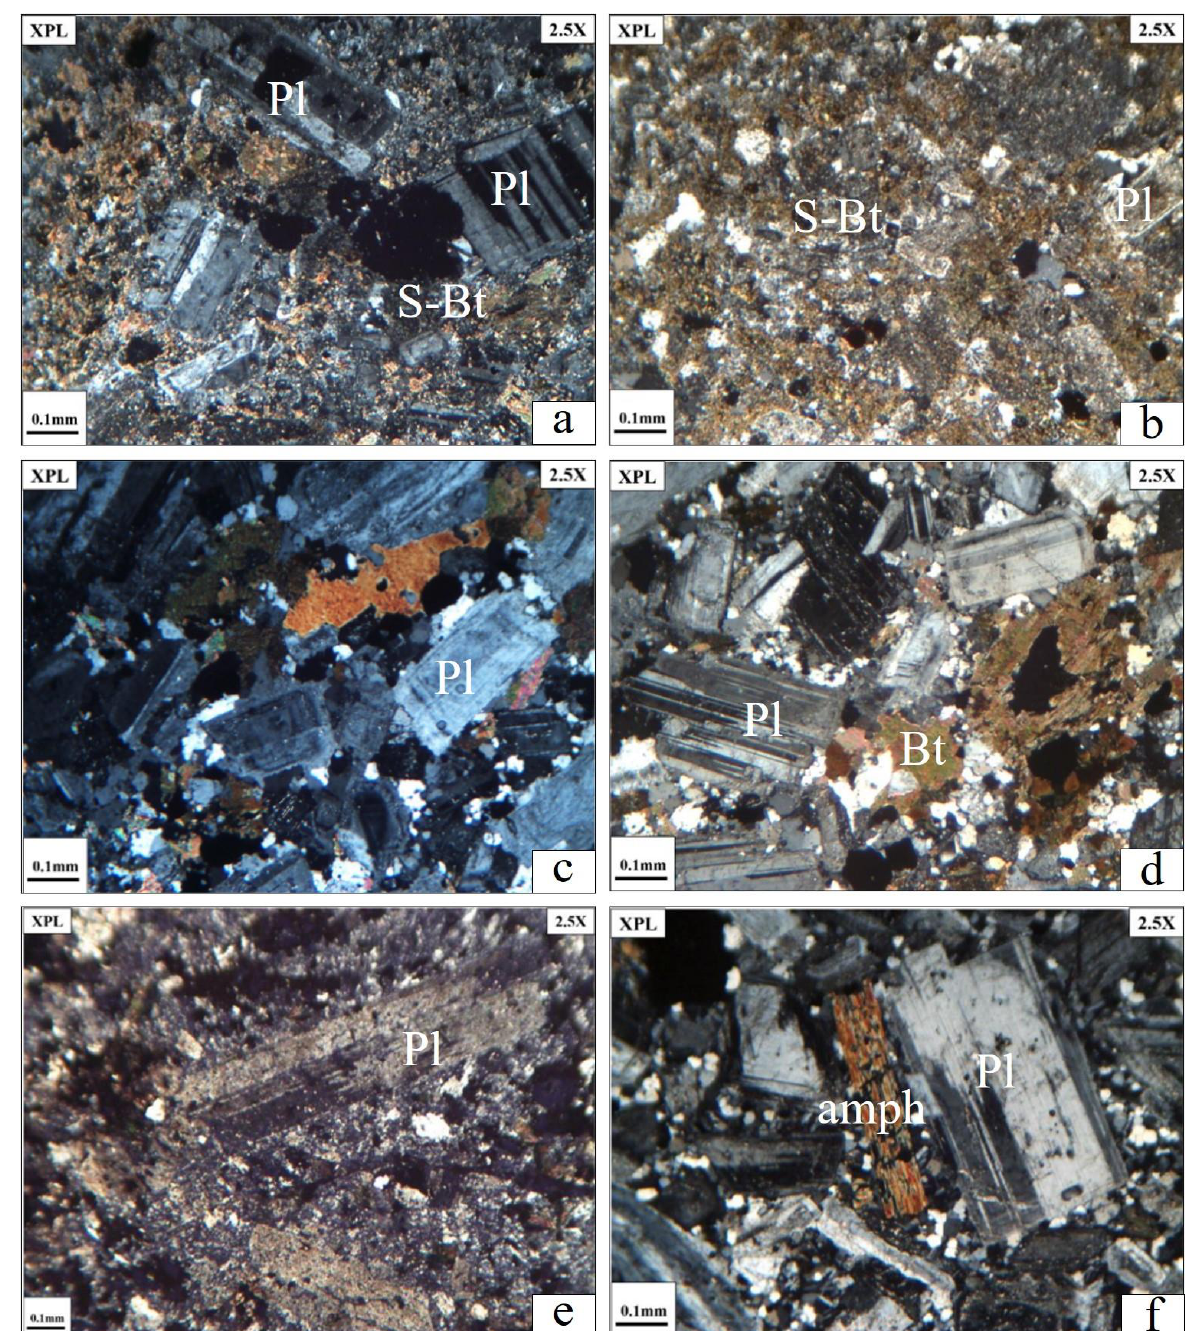
Figure 5. Photomicrographs of selected rocks from Shadan in cross polarized transmitted light. ( a , b ) Mineral assemblages of plagioclase and secondary biotite (originally phenocrysts in a microcrys- talline groundmass) in andesite. ( c ) Mineral assemblages of phenocrysts of plagioclase, hornblende, and quartz with a minor groundmass component in quartz diorite. ( d ) Phenocryst assemblages of medium-grained plagioclase, quartz, and secondary biotite in diorite. ( e ) Medium-grained monzonite with quartz, plagioclase, and alkali feldspar phenocrysts-rich assemblage. ( f ) Phenocrysts of plagioclase, alkali feldspar, and quartz in monzodiorite. Abbreviations: Pl = plagioclase; S-Bt = secondary biotite; Bt = biotite; Amph = amphibole.